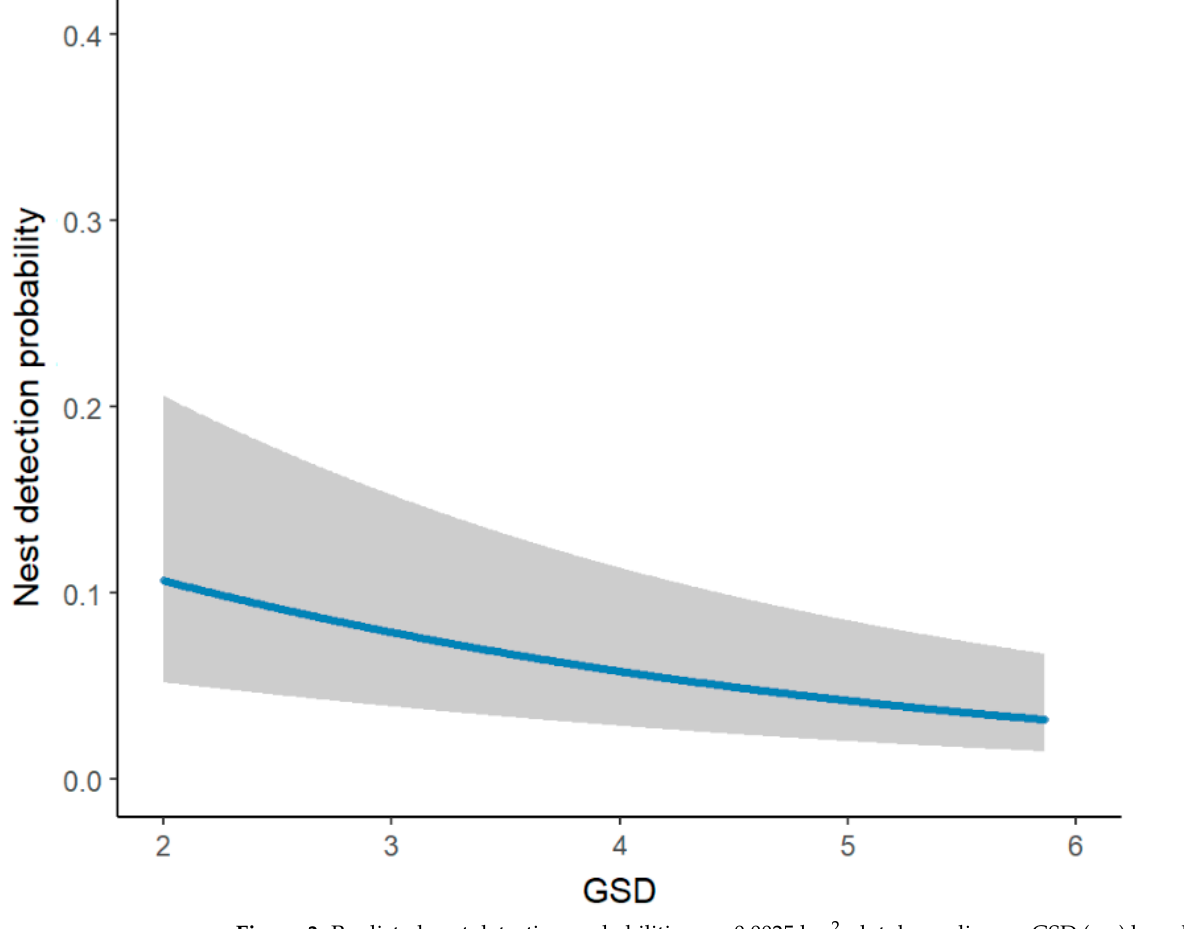
Figure 3. Predicted nest detection probabilities per 0.0025 km 2 plot depending on GSD (cm) based on N-mixture models using data from (2018). Grey lines represent 95% C.I. Detection probability and standard errors were back-transformed from the logit scale to the original scale and visualized using the predict function in the R package unmarked. Table 2. Drone missions with flight characteristics and resulting probability to which real absence of chimpanzee nests can be assumed.